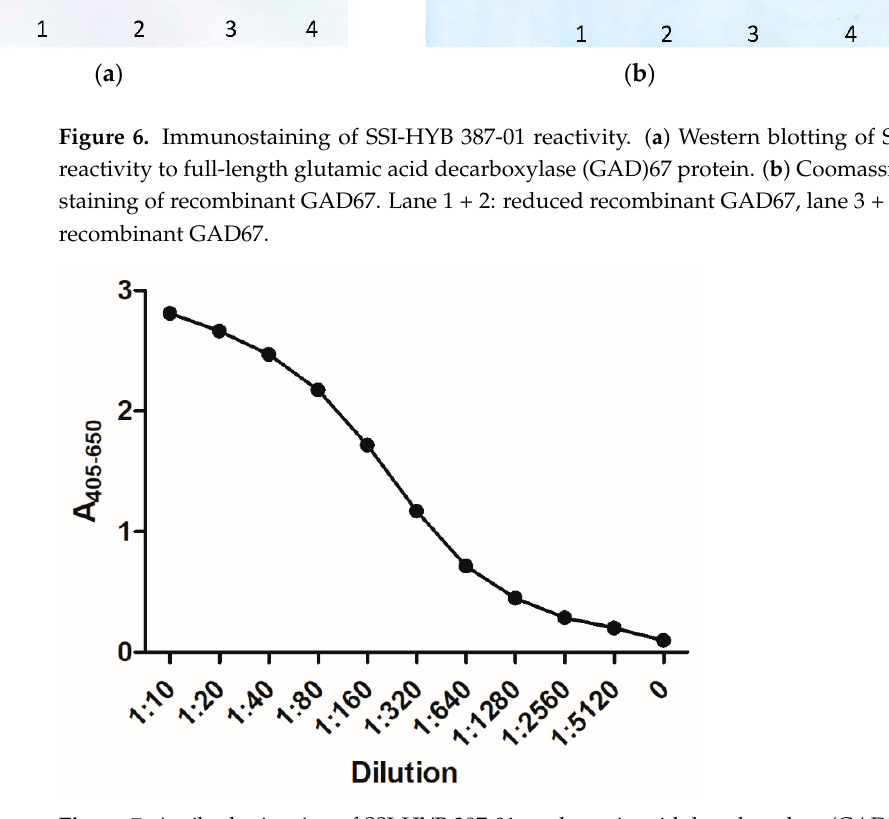
Figure 7. Antibody titration of SSI-HYB 387-01 to glutamic acid decarboxylase (GAD)67 analyzed by enzyme-linked immunosorbent assays.